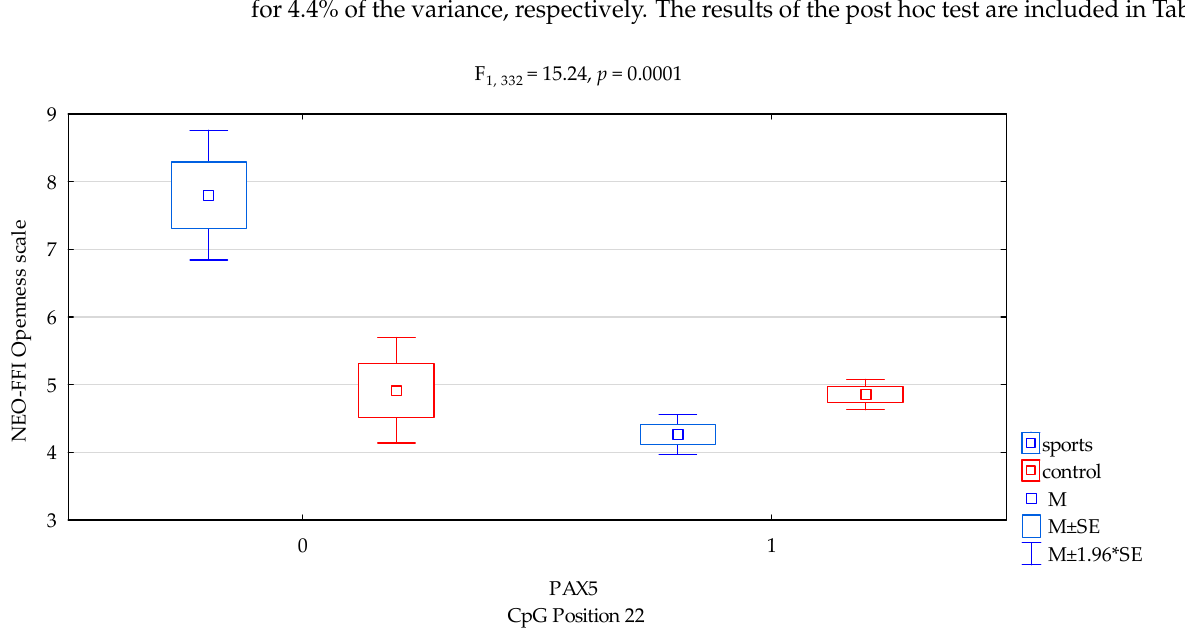
Figure 5. Interaction between sports subjects/control and DAT1 PAX5 CpG sites 22 and NEO FFI Openness scale. Methylation status: yes—1, no—0. M ± SE—mean ± standard error, M ± 1.96*SE—mean ± s1.96*standard error.